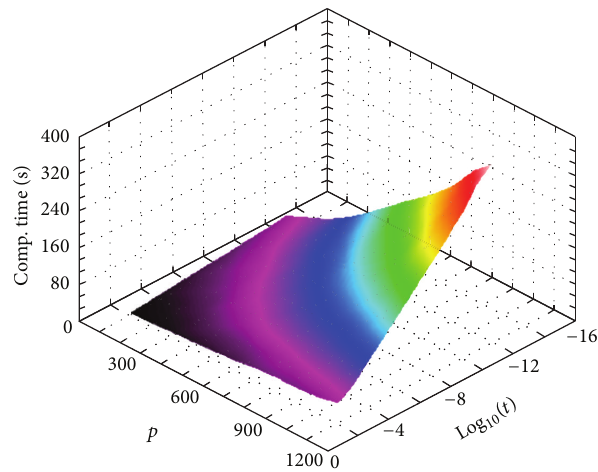
Figure 2: Sensitivity of computational time (sample